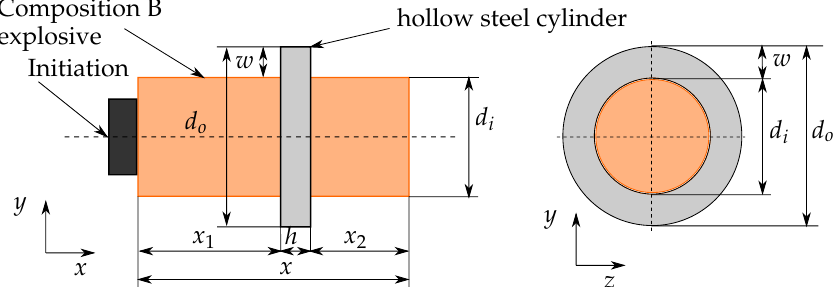
Figure 4. Charge dimensions of the experiment. Constant for all cases: The inner diameter ( d i = 38.1 mm), the outer diameter ( d o = 57.2 mm), the charge extension left ( x 1 = 45 mm), the charge extension right ( x 2 = 32 mm), and the wall thickness of the cylinder ( w = 9.5 mm). (Image similar to [21]).